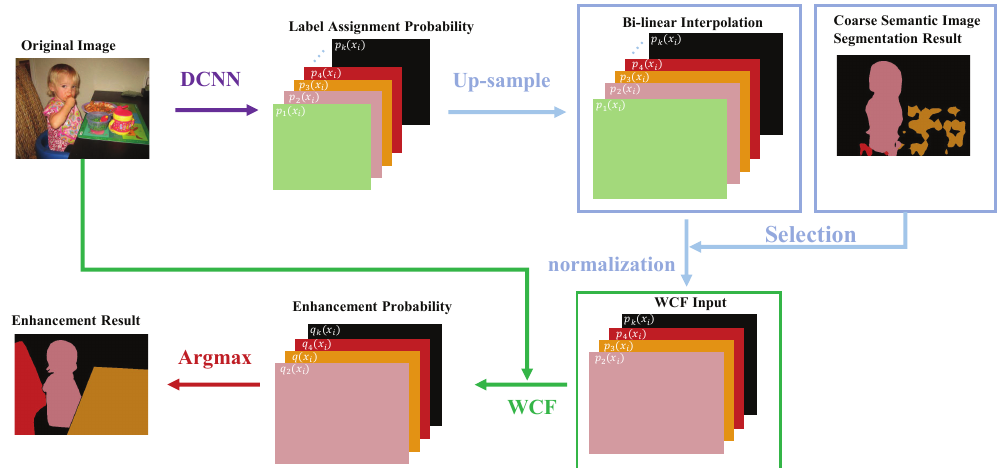
Figure 3. WCF-based enhancement method illustration. The size of the label assignment probability P ( x i ) computed by a deep convolutional neural networks (DCNN) is different from the original image. (i) A bi-linear interpolation stage enlarges the probability maps to the original image resolution. Then, select the classes occurring in the coarse segmentation mask to do normalization. (ii) Use WCF to improve the probability maps. (iii) Use the argmax function to obtain final segmentation